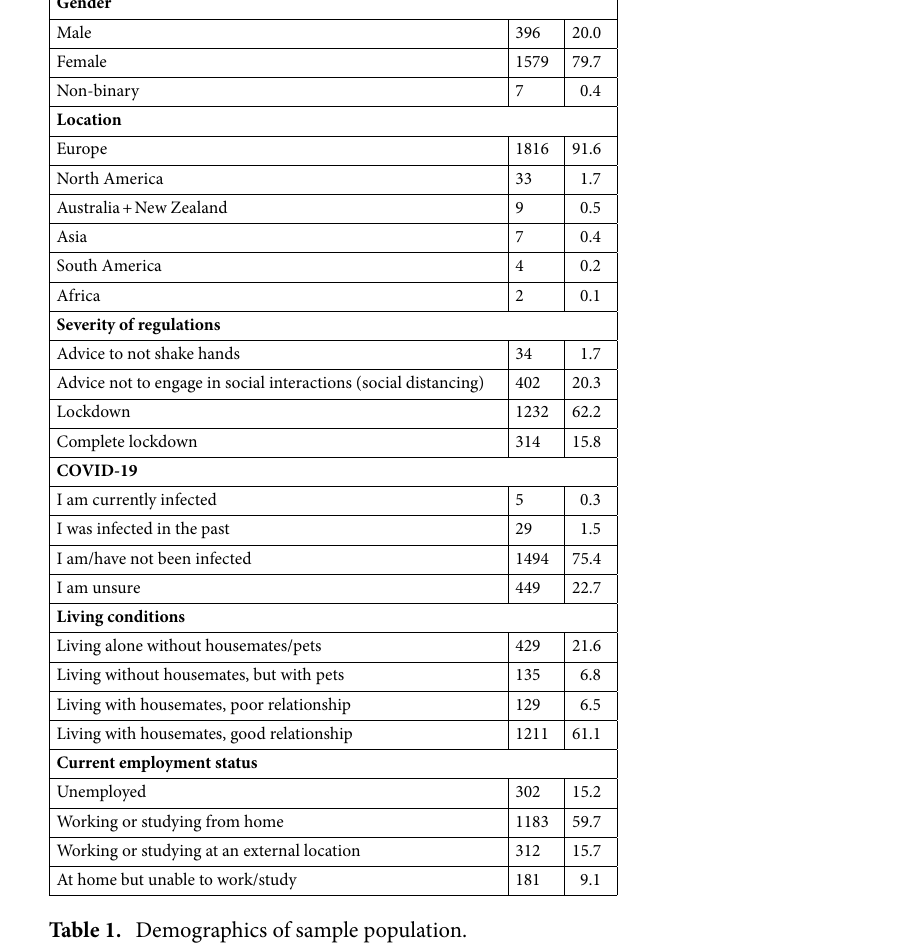
Table 1. Demographics of sample